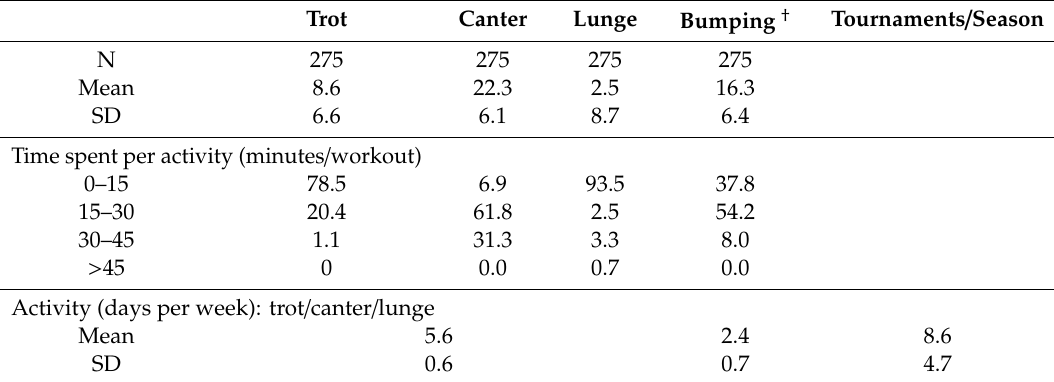
Table 3. Exercise routine (minutes / workout) of Chilean corralero horses.